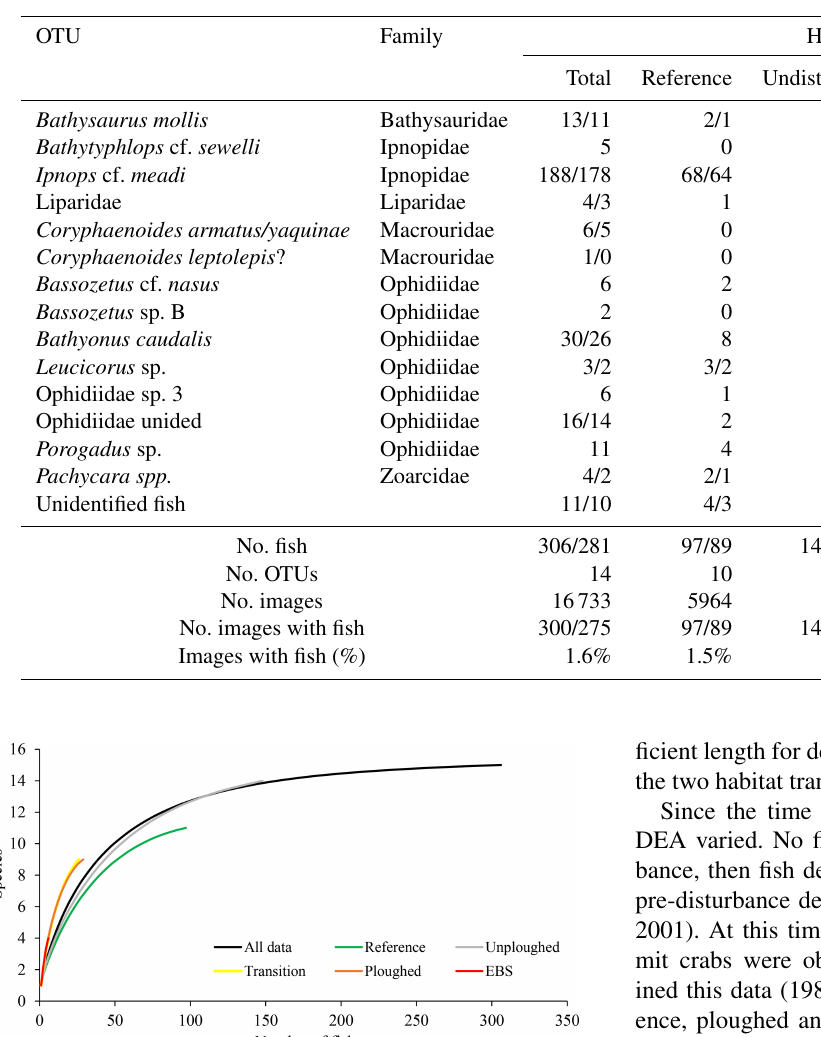
Table 1. Numbers of photo transect (OFOS system) observations (all images/timed images only) for fishes in the DISCOL area by habitat type 26 years after initial experiment. The percentages of images with fishes are calculated from the timed images only.